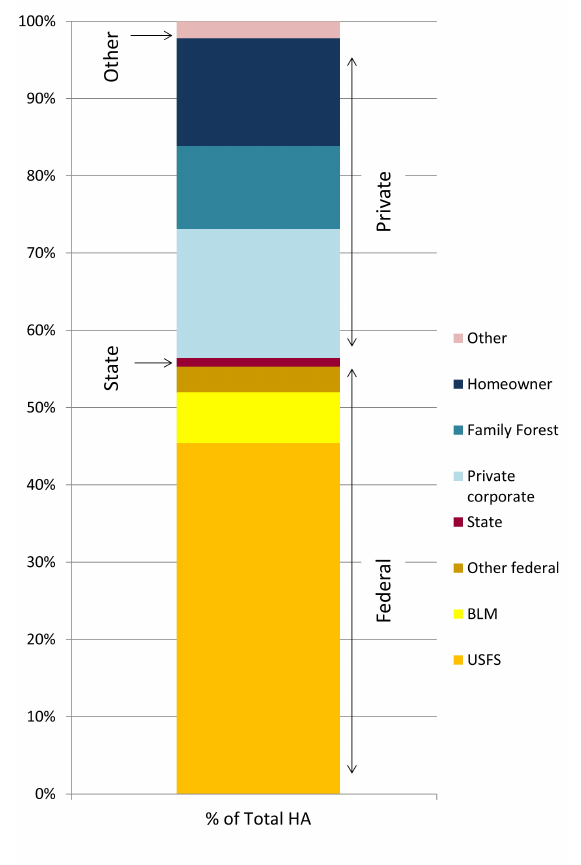
Fig. 2. Percentage of total study area owned by each actor